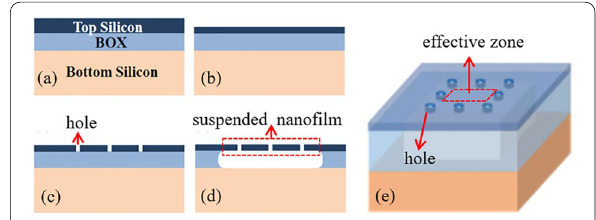
Fig. 1 Fabrication process schematic of the suspended ultrathin samples: a commercial SOI structure, b thinning of top Si film, c etching of holes on the top Si film, d removal of underneath BOX layer by undercut etching process, e 3D schematic of d , and the effectively suspended zone is enclosed by the red